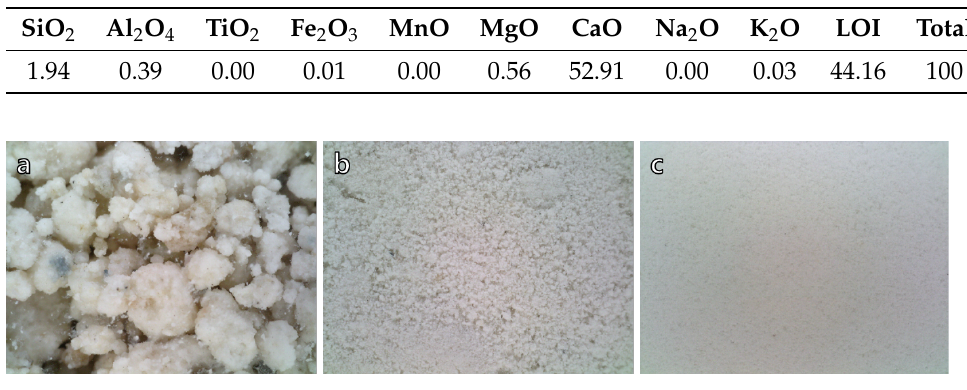
Figure 2. Materials used for experiments. ( a ) Quick lime lumps, ( b ) powdered hydrated lime, ( c ) white cement.